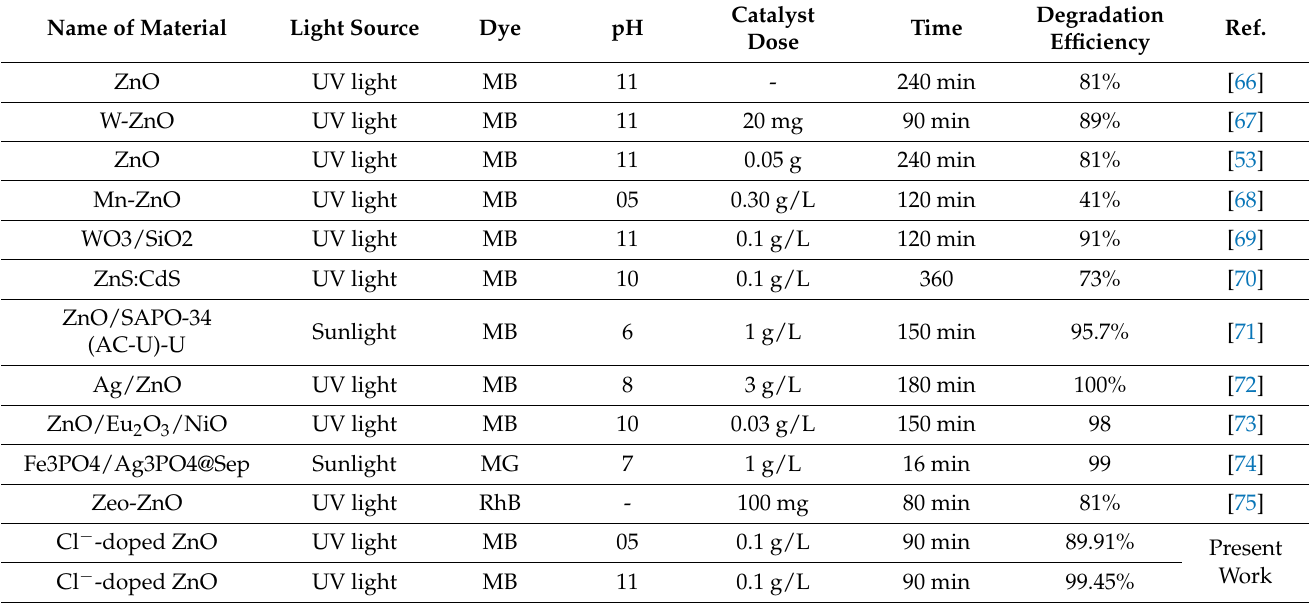
Table 3. Comparison of the degradation efficiency of the 20% Cl − -doped ZnO photocatalyst at pH 5 and 11 with the literature results.